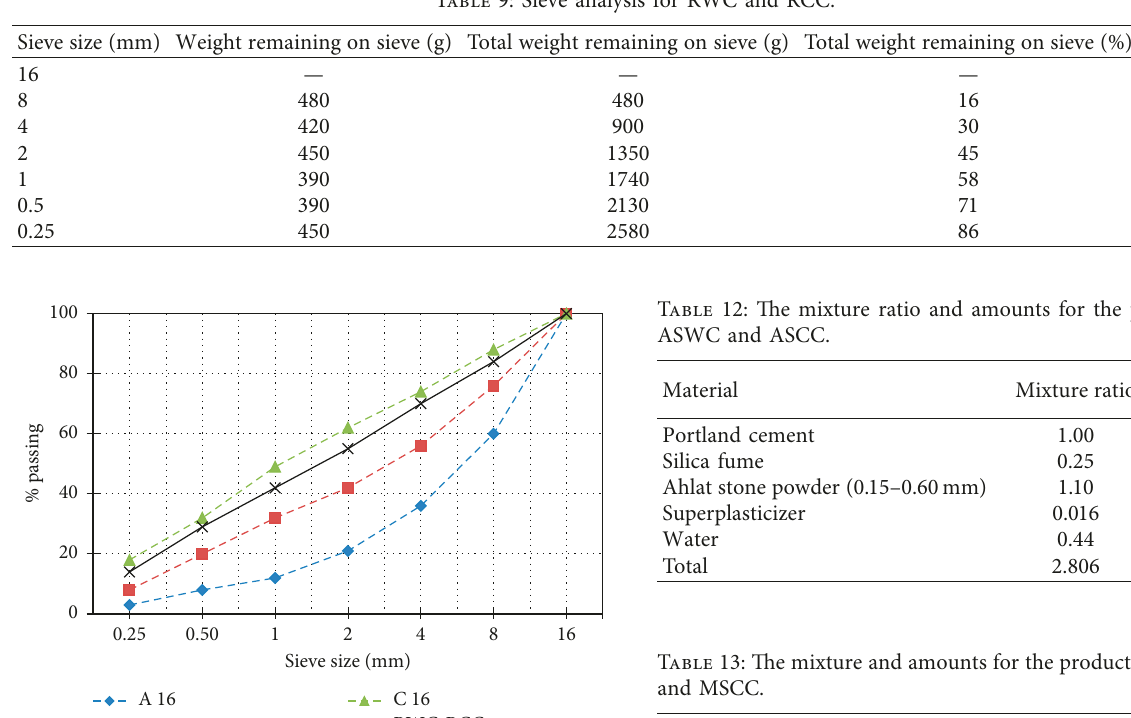
Table 9: Sieve analysis for RWC and RCC.